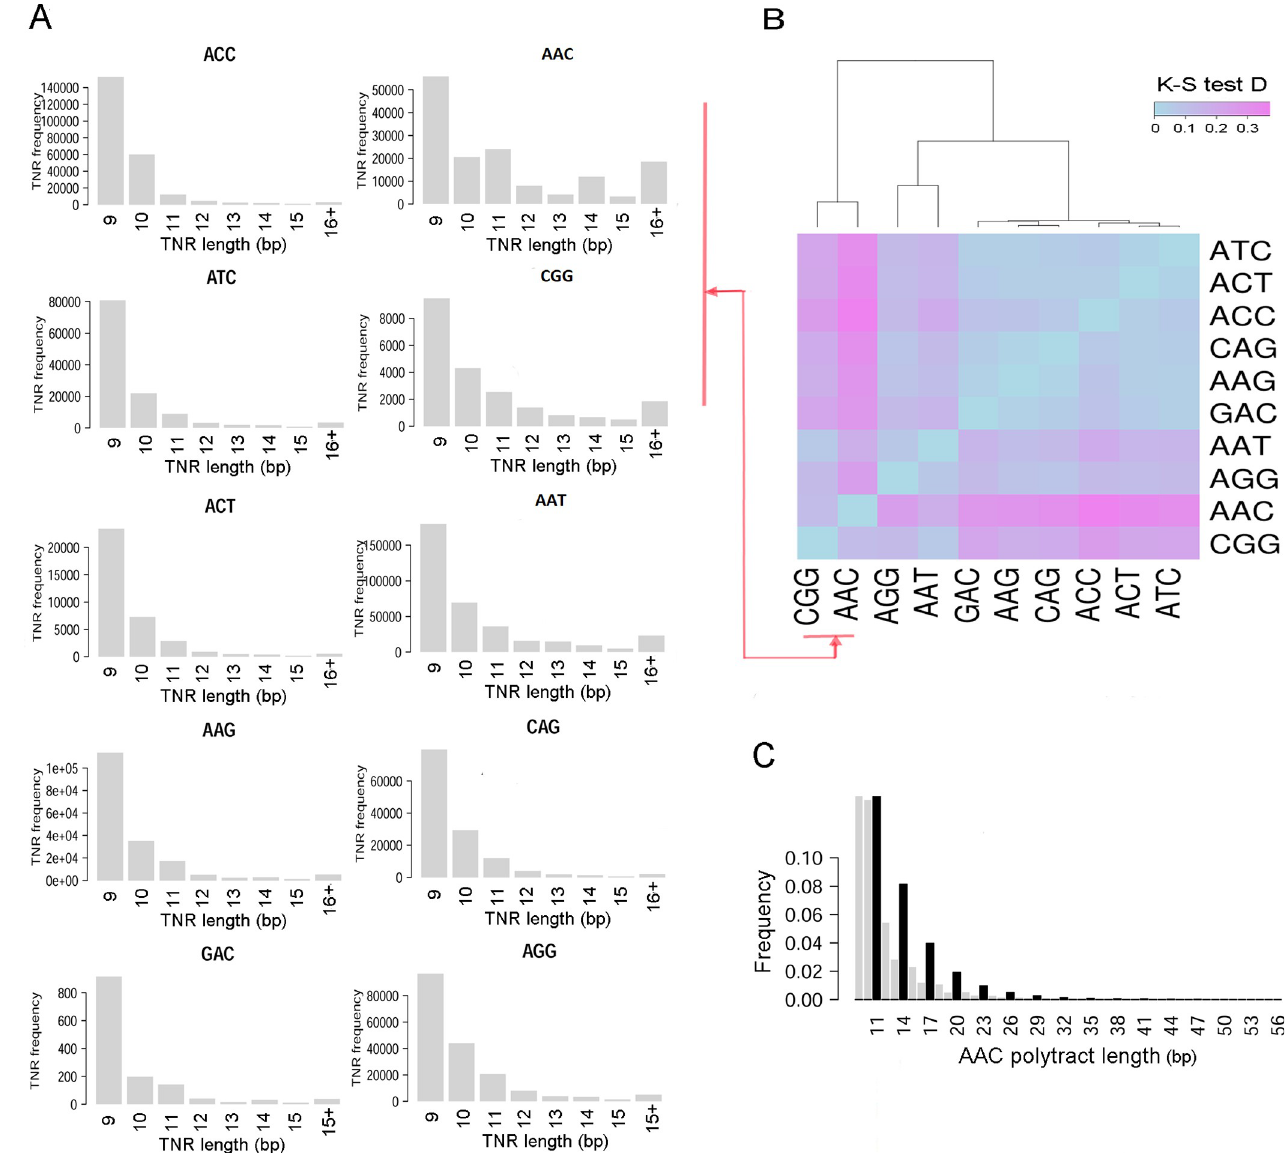
Fig 3. Length distributions of Trinucleotide repeats (TNR) in the human genome. A, polytract length distribution dissected by TNR species. B, heatmap graph showing the Kolmogorov-Smirnov statistics D resulting from pairwise comparisons of polytract lengths among all 10 TNR subtypes. Hierarchical dendrogram highlights CGG and AAC as unique from the rest majority. Distance metric used one minus correlation value and linkage choice was the average method. C, full-range length distribution of AAC polytracts. Dark black bars highlight periodical pre-cycle modes at length 11 bp, 14 bp, 17 bp, etc..